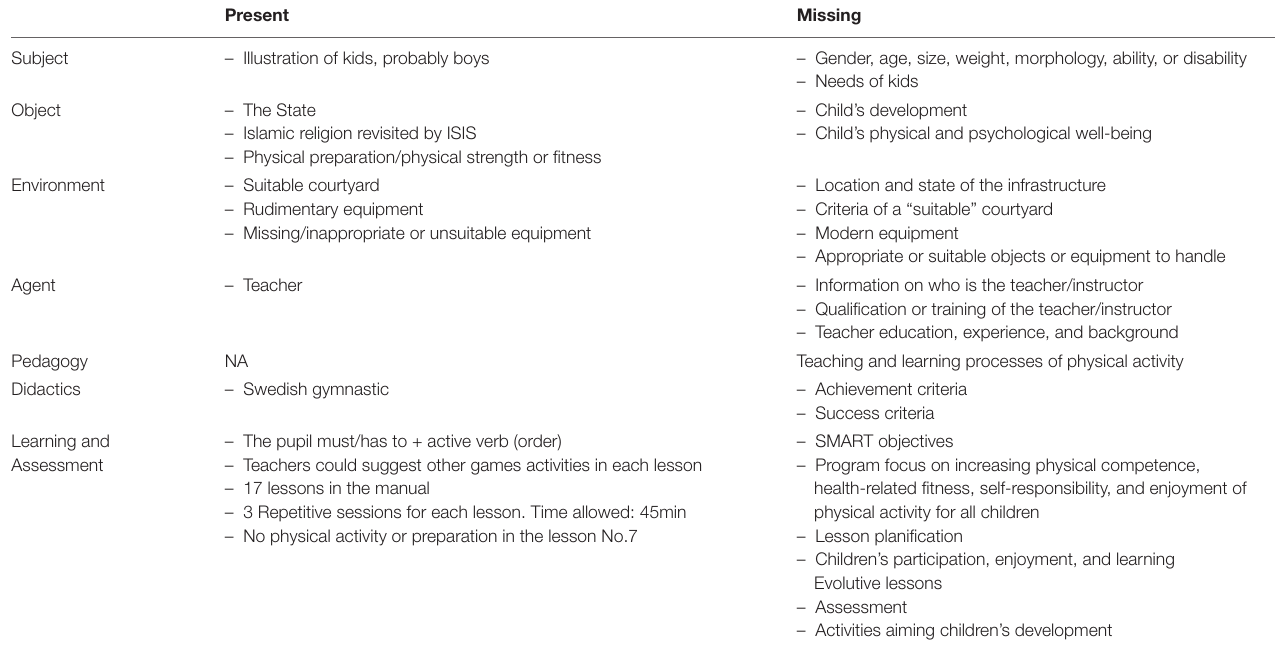
TABLE 1 | Synthesis of the SOEA for the Physical education curriculum of